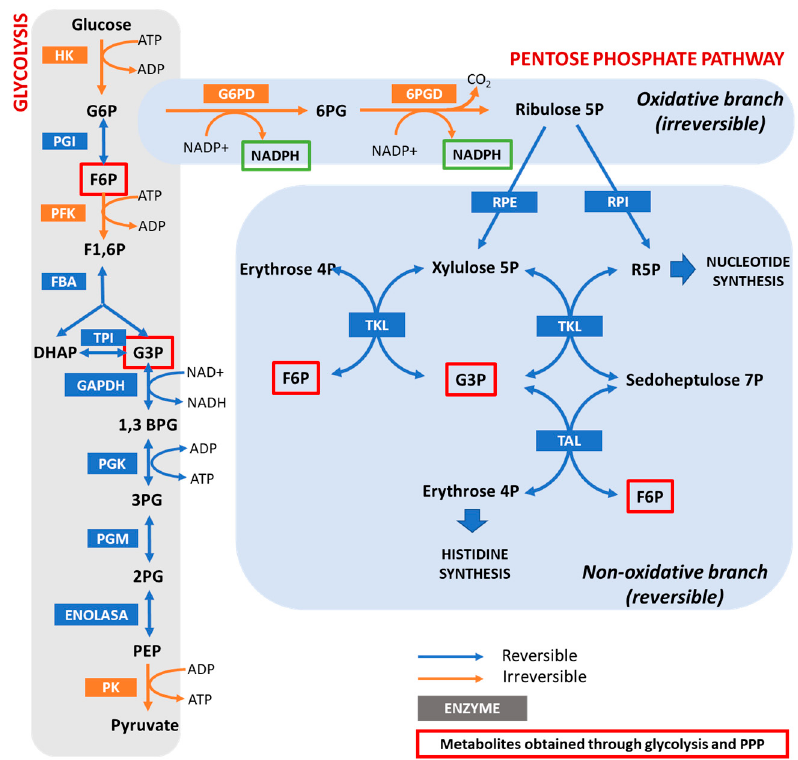
Figure 1. The pentose phosphate pathway and its interrelation with glycolysis. Blue and orange arrows show reversible and irreversible reactions, respectively. Enzyme names are shown in blue and orange boxes. Glycolysis metabolites obtained through the PPP are shown in red squares.